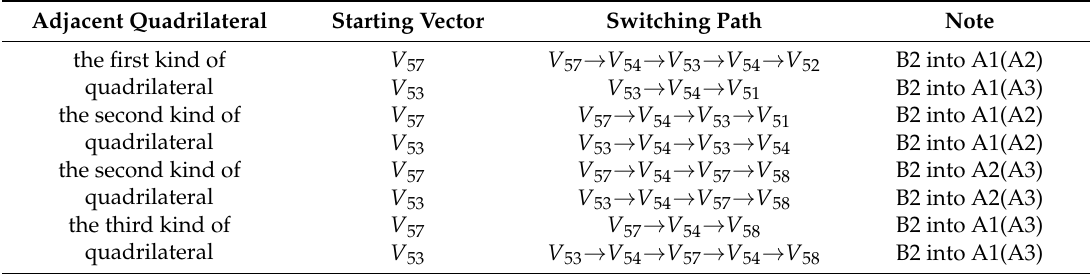
Table 3. Feasible switching paths between the second kind and other kinds of quadrilateral. Adjacent Quadrilateral Note